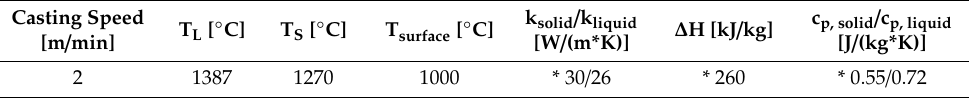
Table 5. Parameters used in the solidifying shell simulation, where k is the heat conductivity, ∆ H is latent heat, and c p is the specific heat.